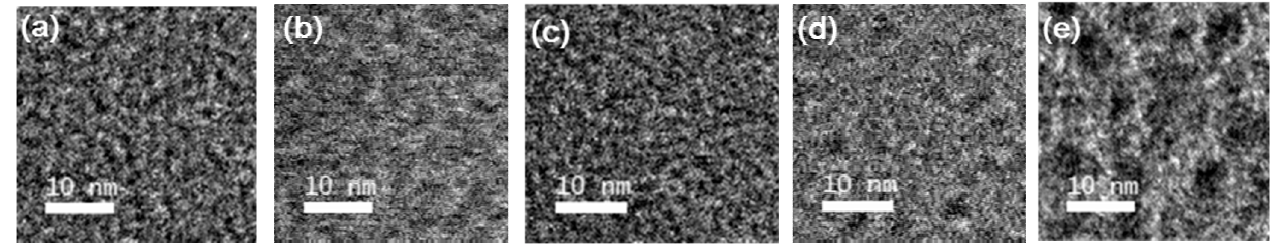
Figure 4. TEM images of the ( a ) Hex-SPAES-30; ( b ) Hex-SPAES-40; ( c ) Phe-SPAES-30; ( d ) Phe-SPAES-40; and ( e ) Nafion 212 membranes.